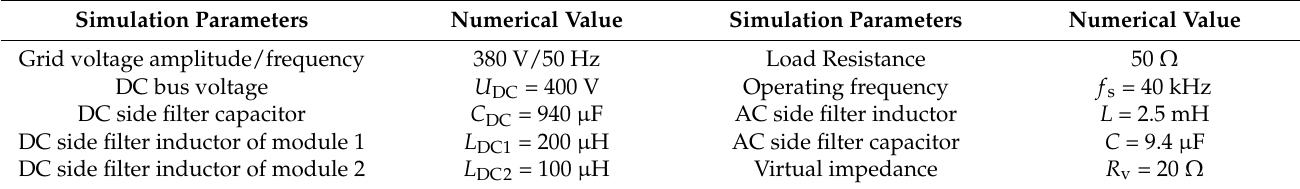
Table 1. Simulation parameters for parallel